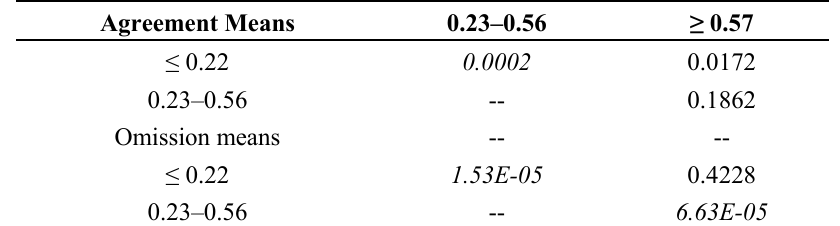
Table 6. Results of pairwise comparisons of agreement and omission rate means as a function of NDVI=based vegetation cover class. Significant tests ( p = 0.01) are in italics . Only moderate and low agreement rates differ while low vegetation cover classes had highest omission